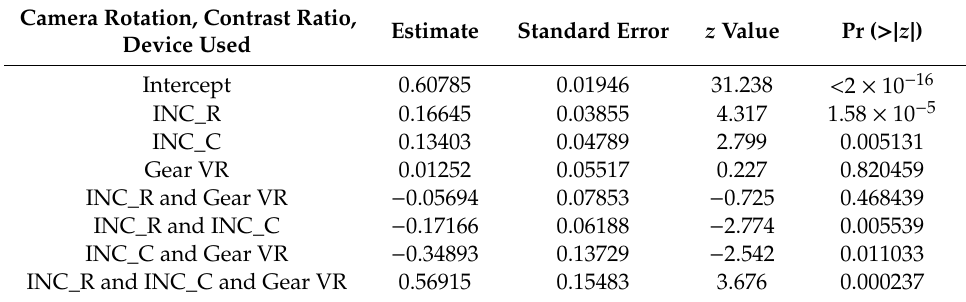
Table 36. Results of the logistic regression analysis of the model with the variables camera rotation, contrast ratio and the device used, allowing interactions all